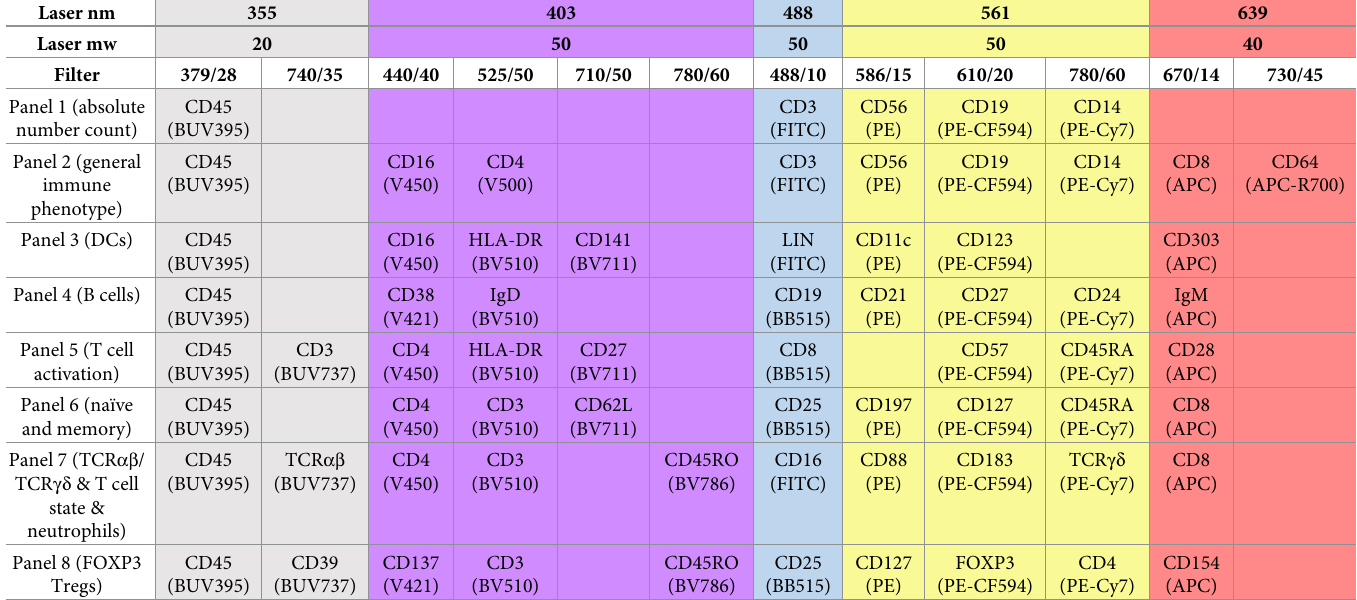
Table 2. The finalised panels on the 5 laser